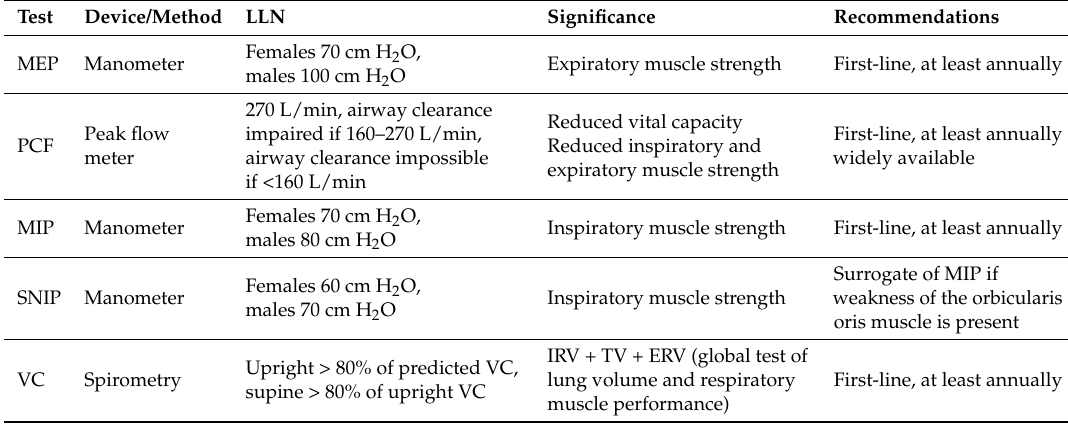
Table 1. Practical recommendations for inspiratory and expiratory muscle testing in LOPD. LLN,